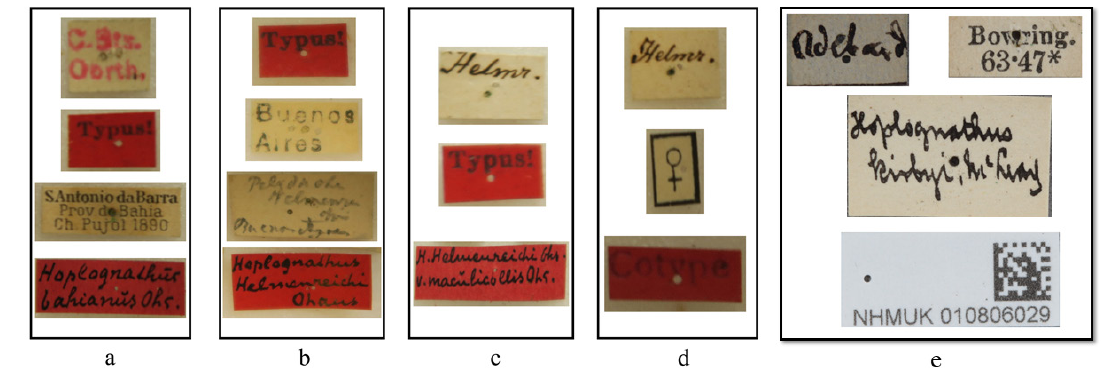
Fig. 2. Labels. a . Oplognathus bahianus Ohaus, 1912, syntype, ♂. b . O. helmenreichi Ohaus, 1905, holotype, ♂. c–d . O. helmenreichi var. maculicollis Ohaus, 1914. c . Syntype ♂. d . Syntype ♀. e . O. kirbii MacLeay, 1819, neotype,